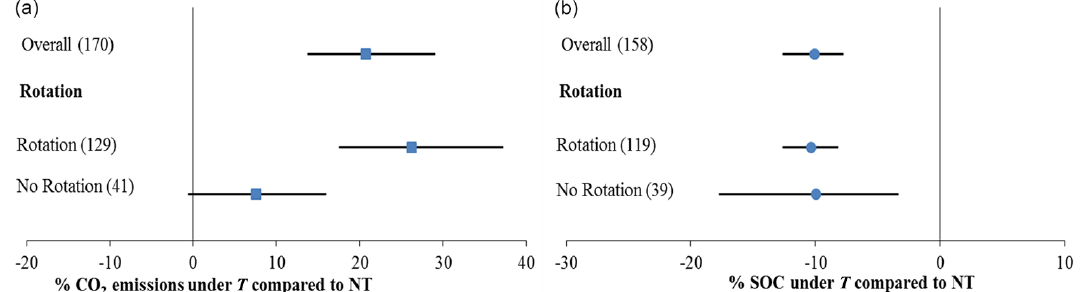
Figure 8. Percent change in (a) soil CO 2 emissions and (b) SOC in tillage ( T ) soil compared to no-tillage (NT) as a function of crop rotation. The numbers in the parentheses indicate the direct comparisons of the meta-analysis. Error bars are 95% confidence intervals.